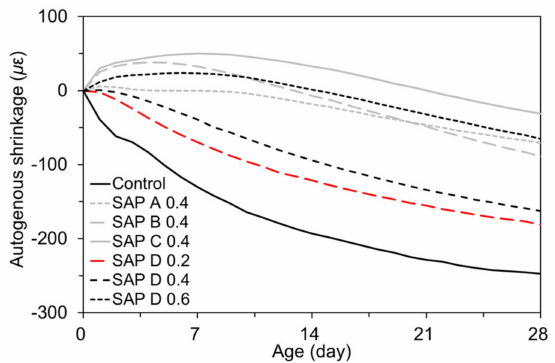
Figure 13. Effects of SAP addition on autogenous shrinkage